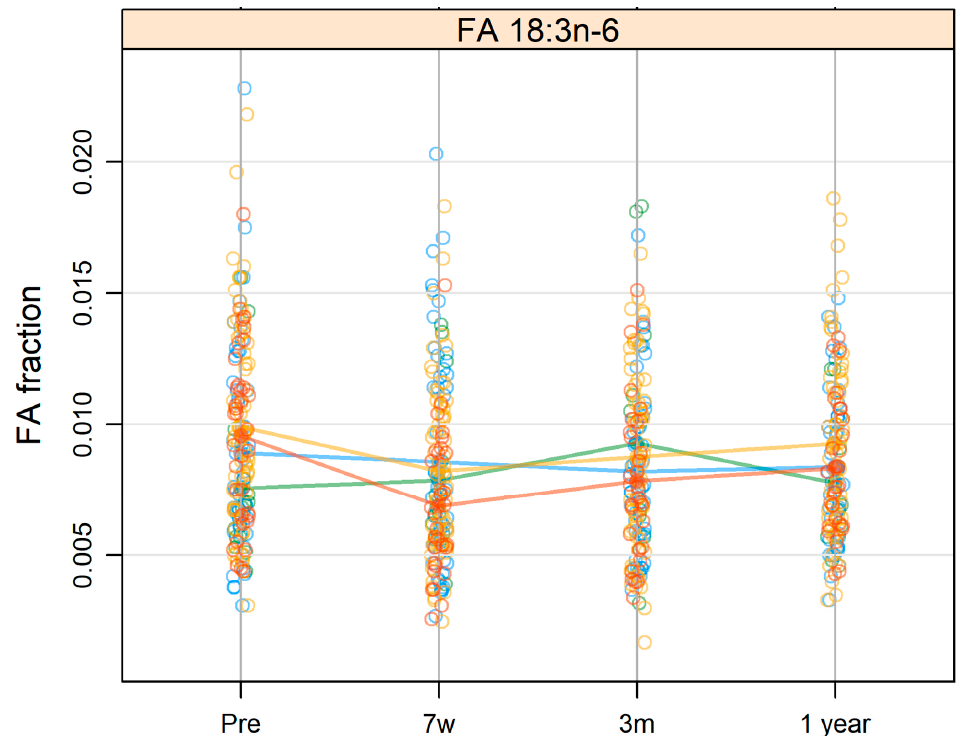
Figure 3. Levels of FA 18:3n-6 in patients with head and neck cancer divided into Body mass index (BMI) groups (green line: underweight;, blue line: normal weight;, yellow line: overweight;, red line: obese) at pre-treatment (pre), at 7 weeks after the start of treatment (7w), and at 3 months (3m) and 1 year (1 year) after the termination of treatment. The values of the FA are presented in relation to the total amount of FAs.